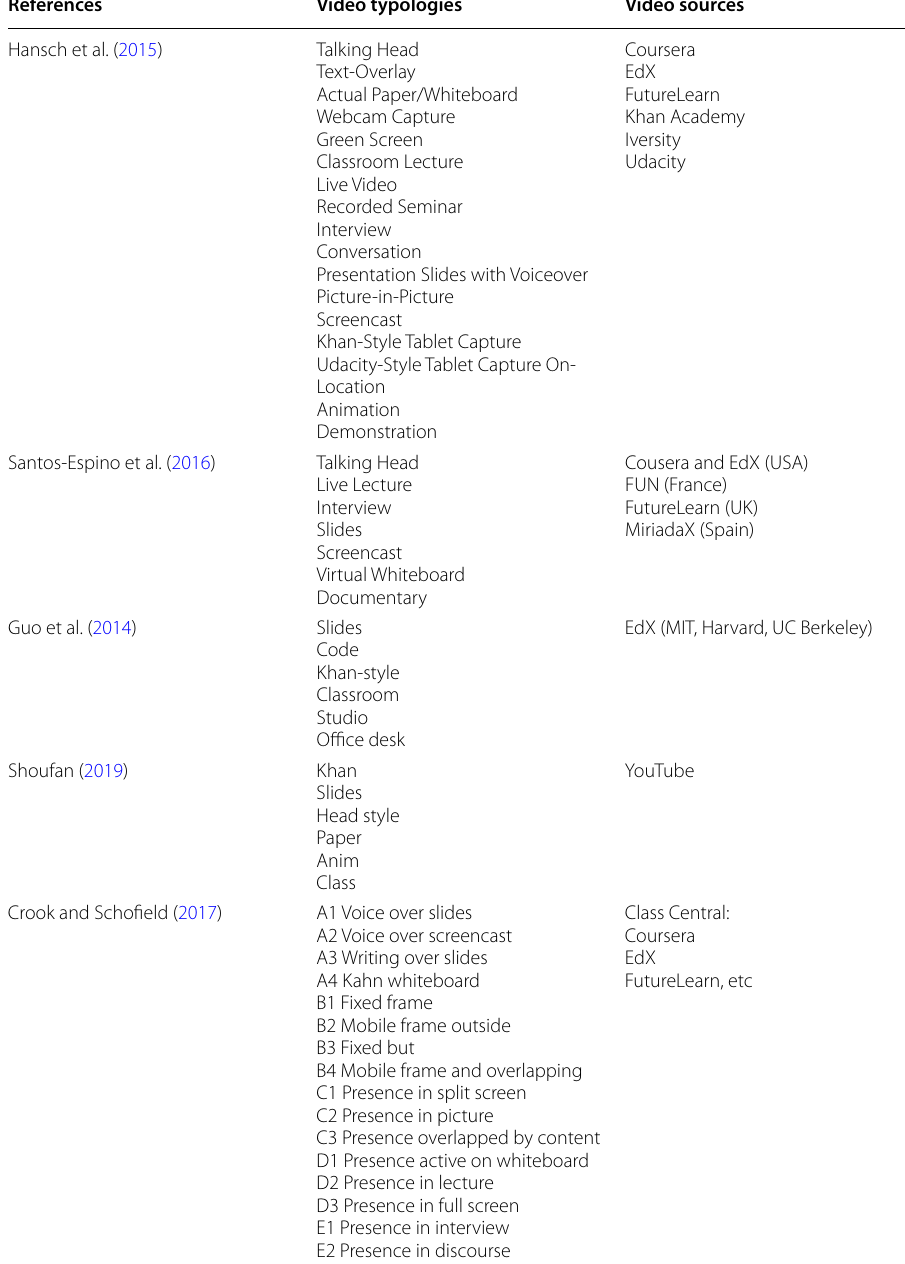
Table 3 Classification of video type used in education published in the literature; only Snowball and McKenna (2017) considers student-generated